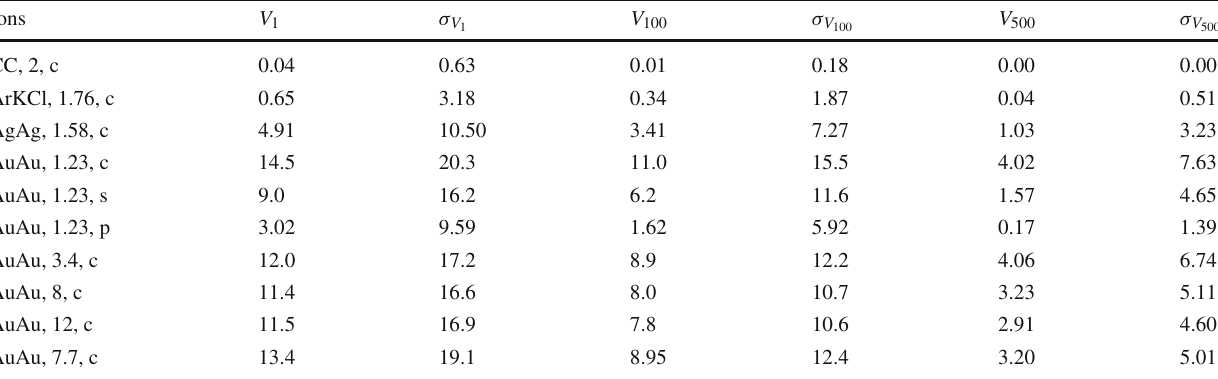
Table 7 Results for X ebe < 0 . 3 and Y ebe < 0 . 1